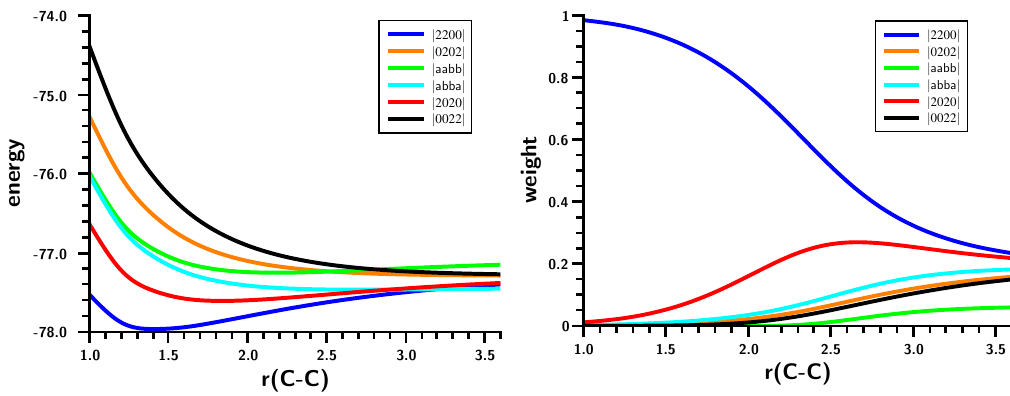
Figure 3. Carbene dimerization. Energy ( left ) and weights ( right ) of the six most important molecular orbital (MO)-CSFs. Energy in Hartrees; bond length in Å.